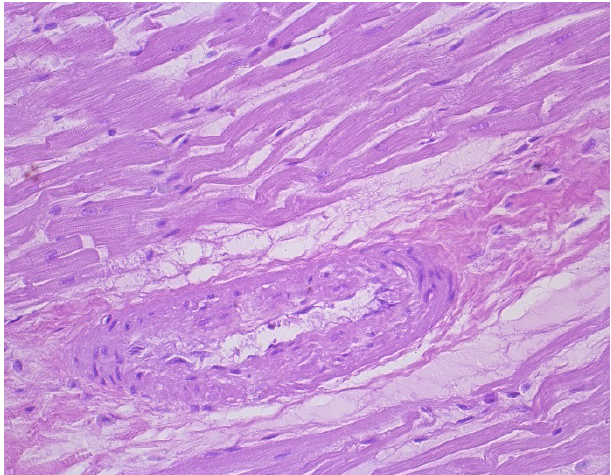
Fig. 4. Heart. In the arterioles, elastic twisting fibers are swollen, loose, and the cytoplasm of muscle fibers is en- lightened. McManus. EP. 10, lens. 40